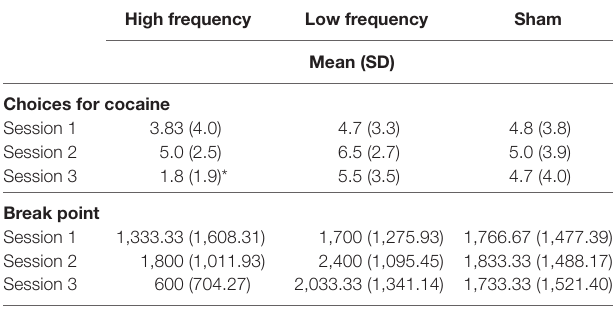
three repetitive transcranial magnetic stimulation (rTMS) groups (Sham, low frequency, or high frequency treatment) on cocaine self-administration